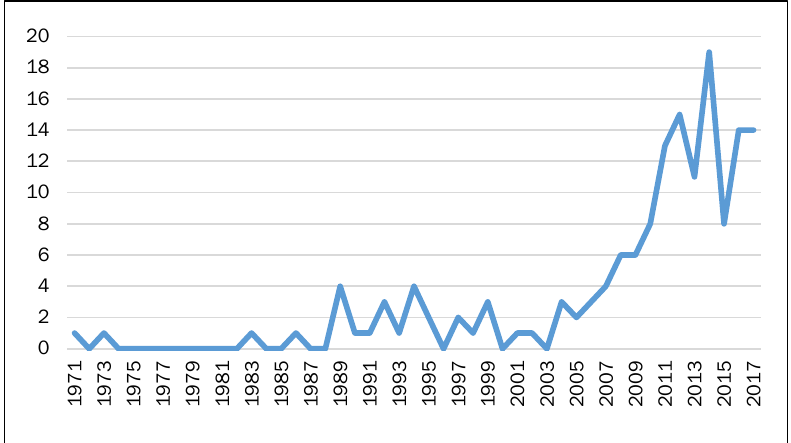
Figure 3. Number of Food Forest Started by Year, 1971–2017 (n=155)